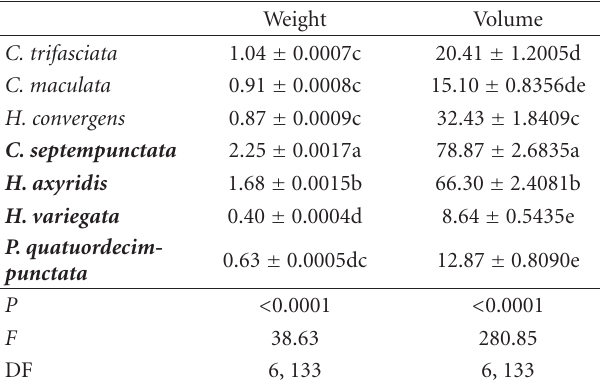
Table 7: Mean ( ± SE) weight (mg) and volume (mm 3 ) of lady beetle species ( N = 20) used in laboratory trials. Means in each column with the same letter are not significantly di ff erent (Tukey’s HSD tests, P < 0 . 05). Nonnative species are printed in bold